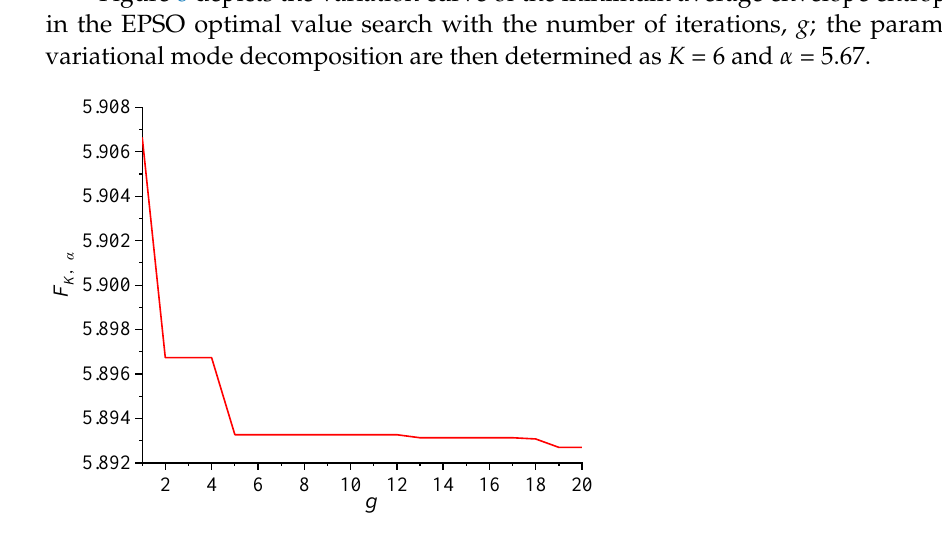
0 Figure 9. EVMD results of the first 70 points in the wind speed series. Figure 9. EVMD results of the first 70 points in the wind speed